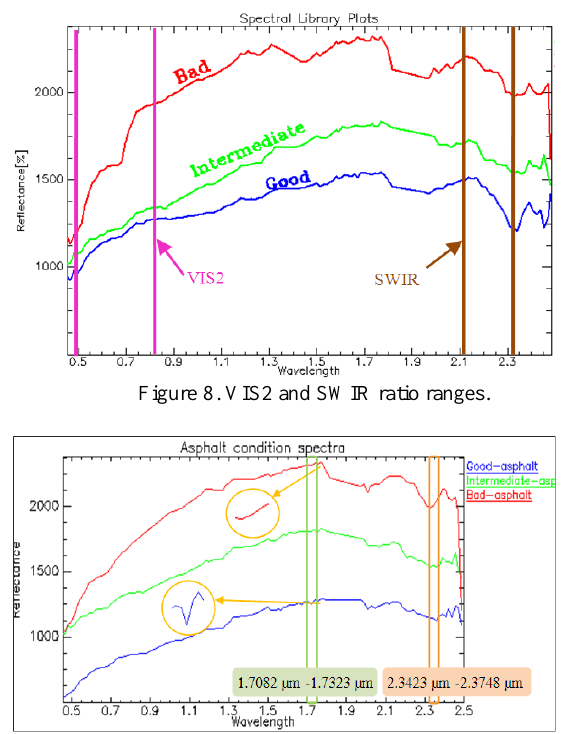
Figure 9. Hydrocarbon absorption band ranges.